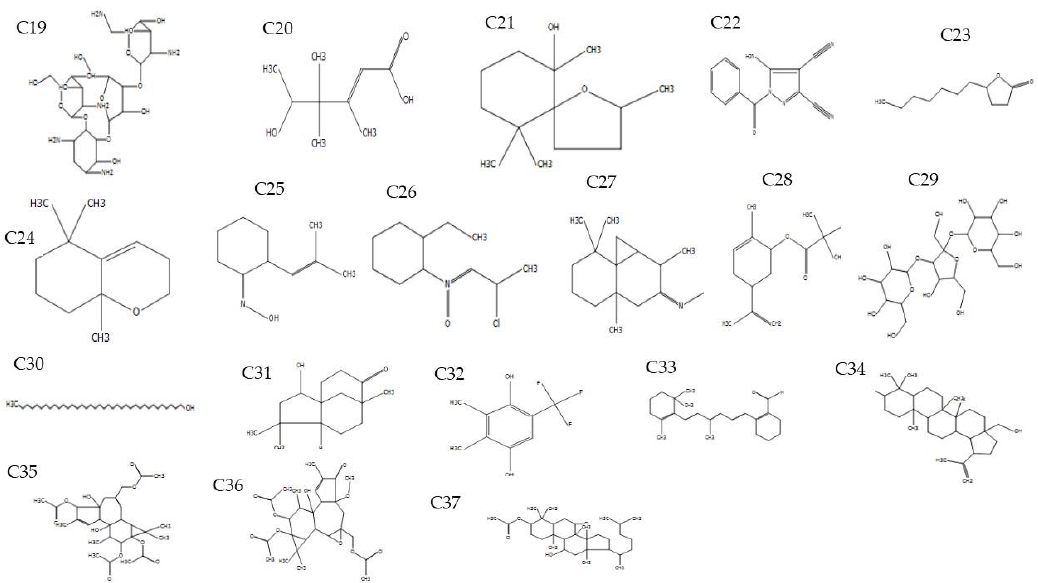
Figure 2. Chemical structures of compounds identified in ethanolic extract of A. longiloba fruit. (C19-C37). * C-compound.